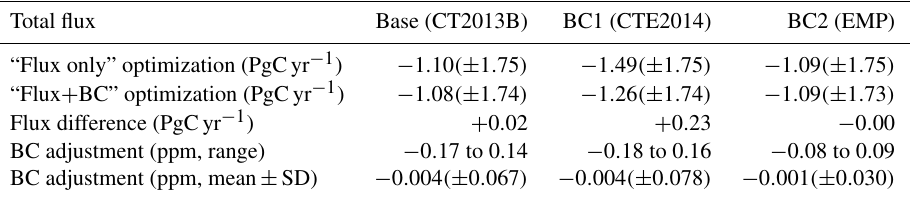
Table 4. Comparison of the optimized annual net biosphere fluxes (PgCyr − 1 ) and the adjustment of CO 2 boundary conditions (BCs, ppm) using different prior lateral BC products (CT2013B, CTE2014, and EMP) and optimization techniques (“Flux only” or “Flux + BC”). The annual net biosphere flux difference is calculated from the “Flux + BC” optimization minus “Flux only” optimization. The values in brackets are flux